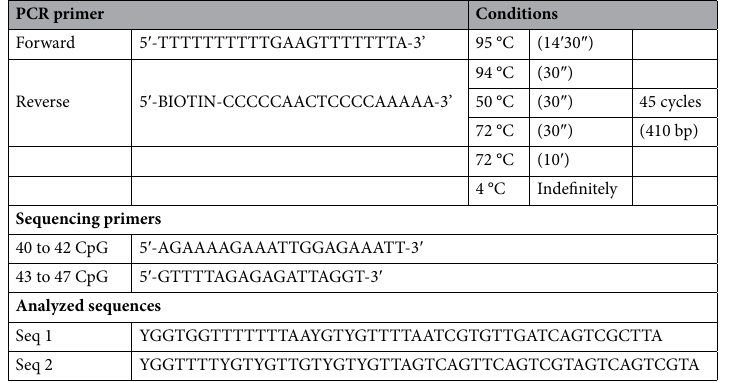
Table 1. PCR and Pyrosequencing primers and conditions.